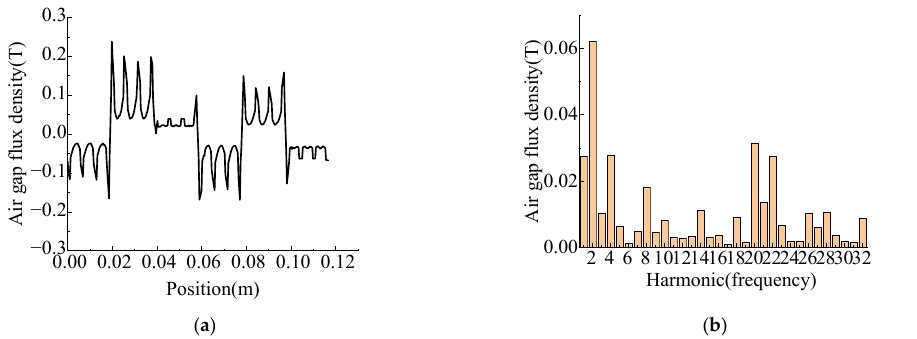
Figure 2. Analysis of air gap flux density and harmonic generated by permanent magnet array: ( a ) Air gap magnetic density ( b ) Harmonic content in air gap.